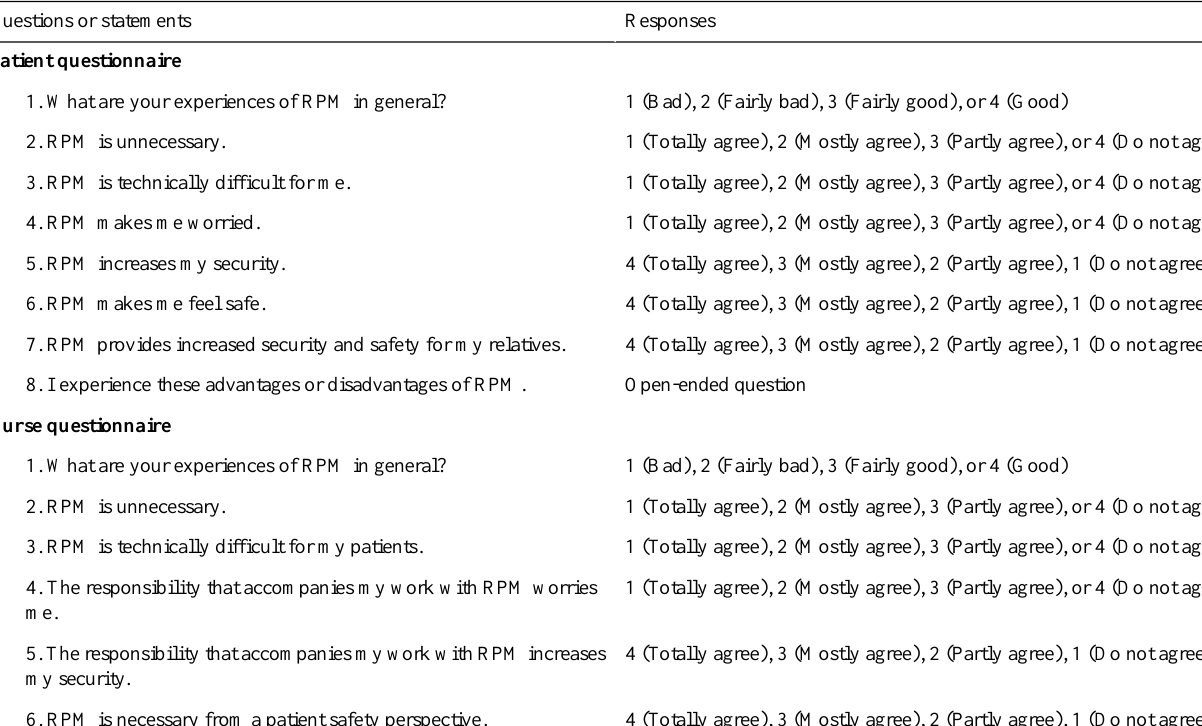
Table 1. Questionnaire items and responses to assess patients’and nurses’experiences of remote patient monitoring